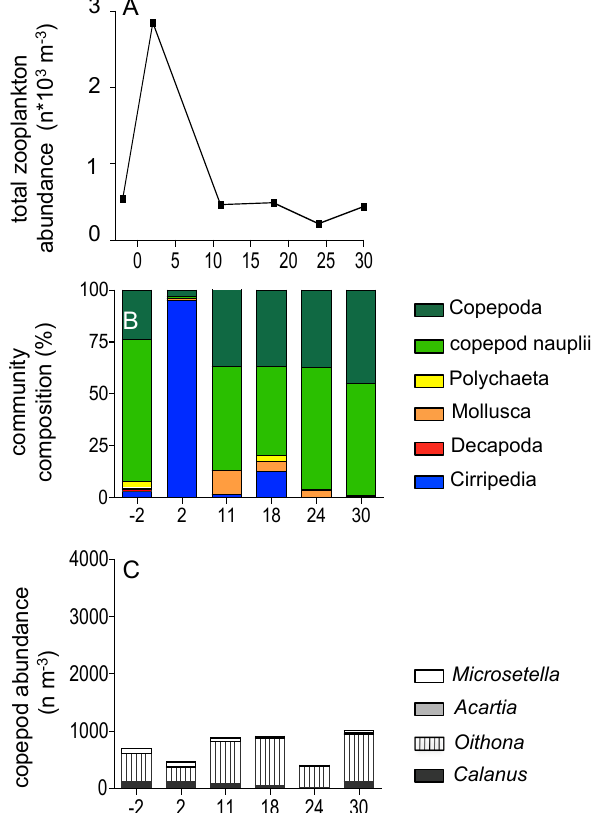
Fig. 2. Development of the mesozooplankton in Kongsfjorden. Pre- sented are total abundance (A) , community composition (B) and abundance and taxonomic composition of the copepod population (C) . The copepod data include both copepodites and adults; cope- pod nauplii are presented as a different group. Please, note that the scales are